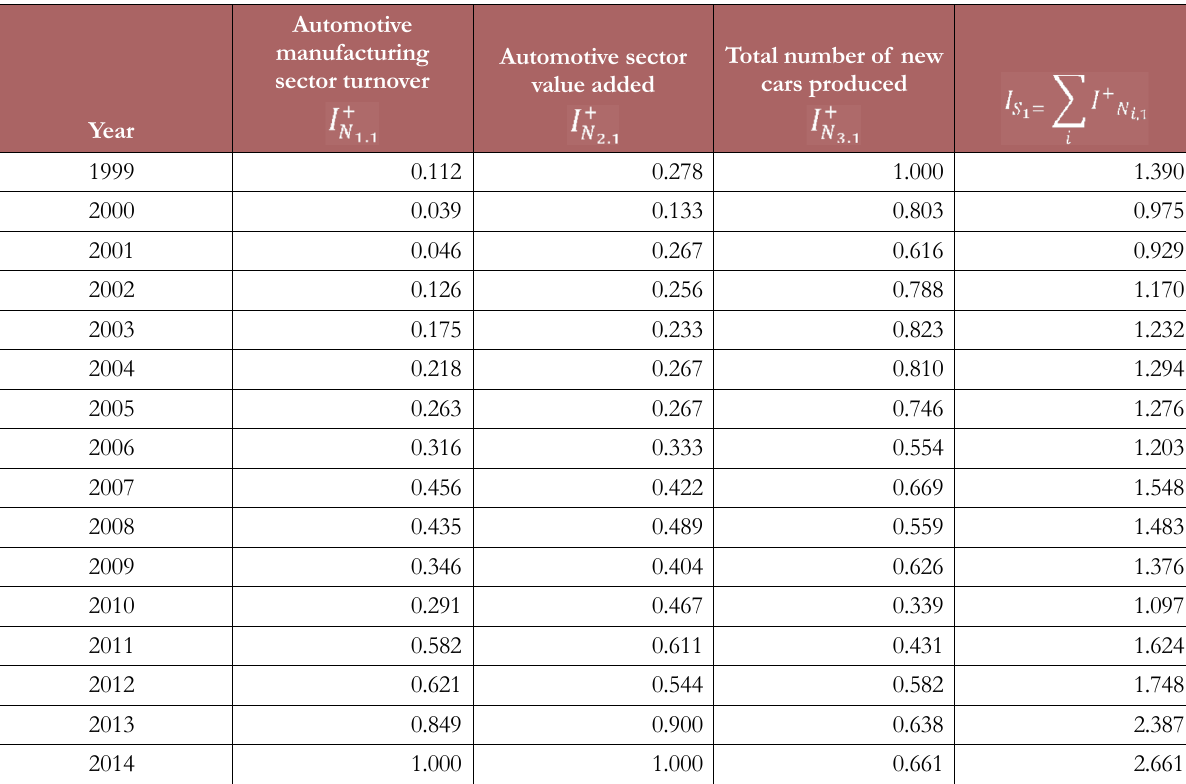
Table 5. Determination of the economic sustainability index ( )